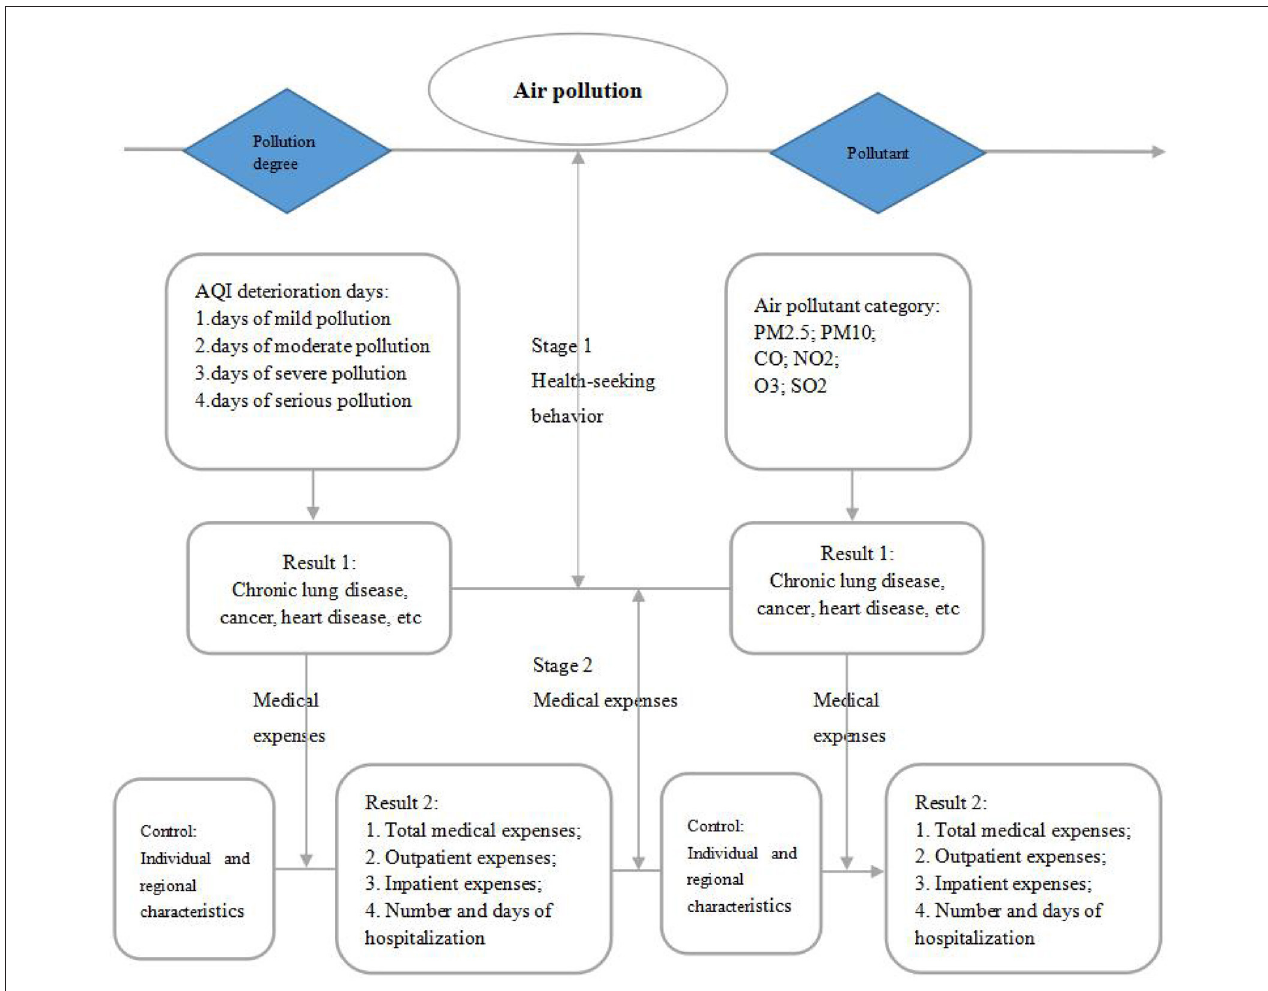
FIGURE 1 | Heckman two-stage model (data source: made by